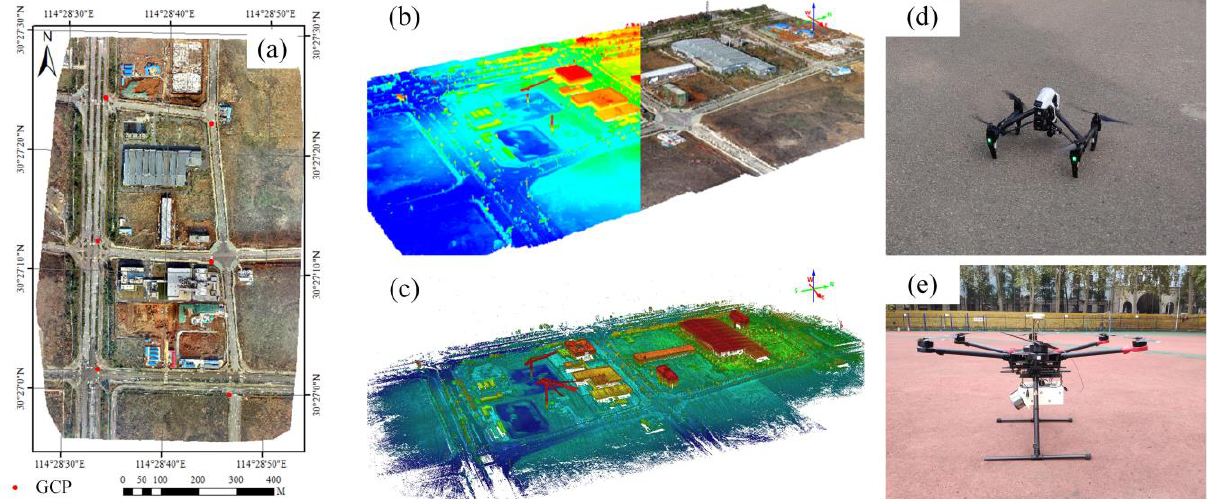
Fig.4 Data collection. (a) Orthophoto of the calibration field. (b) Aerial-triangulated point clouds. (c) ULS point clouds. (d) UAV for image collection. (e) Low-cost UAV-LiDAR system: